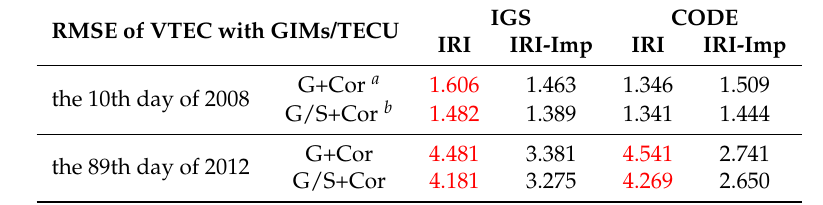
Table 5. Sensitivity of different background fields to occultation observation data on sea and land (red text, significantly improved